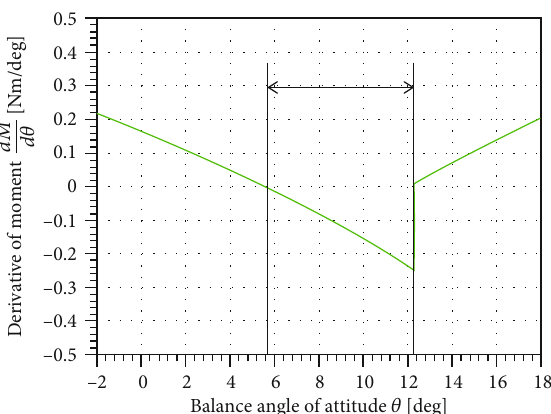
Figure 7: The derivative of the pitting moment as a function of the balance angle of